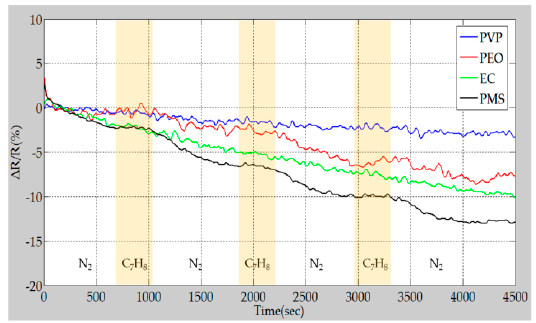
Figure 13. Repeatability test of gas sensor array at 10 ppm toluene.